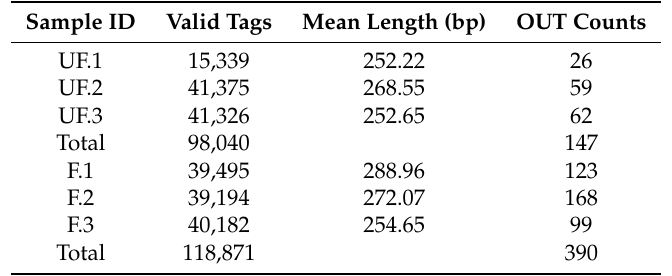
Table 1. Sequencing and analysis results of the non-fertilized and fertilized eggs. Figure 1. Difference of appearance and Yeast-like symbiont (YLS) number in fertilized and non- fertilized eggs of Nilaparvata lugens : ( A ) non-fertilized eggs; ( B ) fertilized eggs.